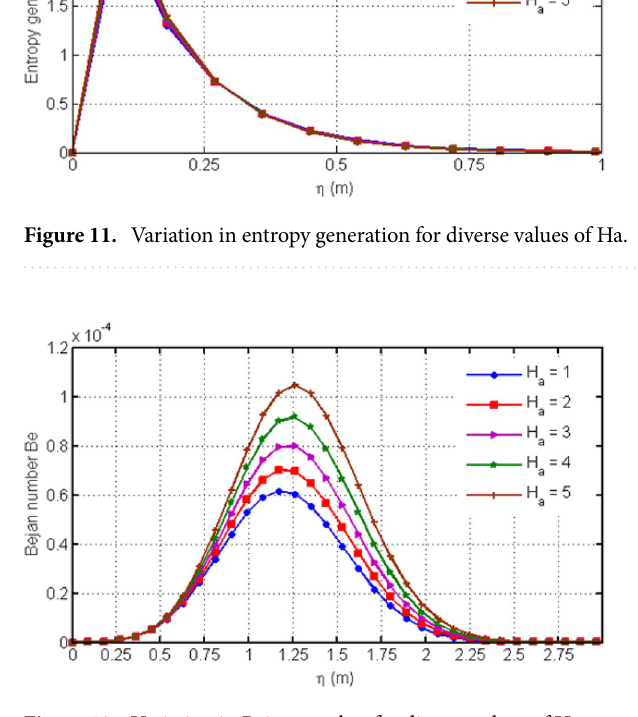
Figure 12. Variation in Bejan number for diverse values of Ha.